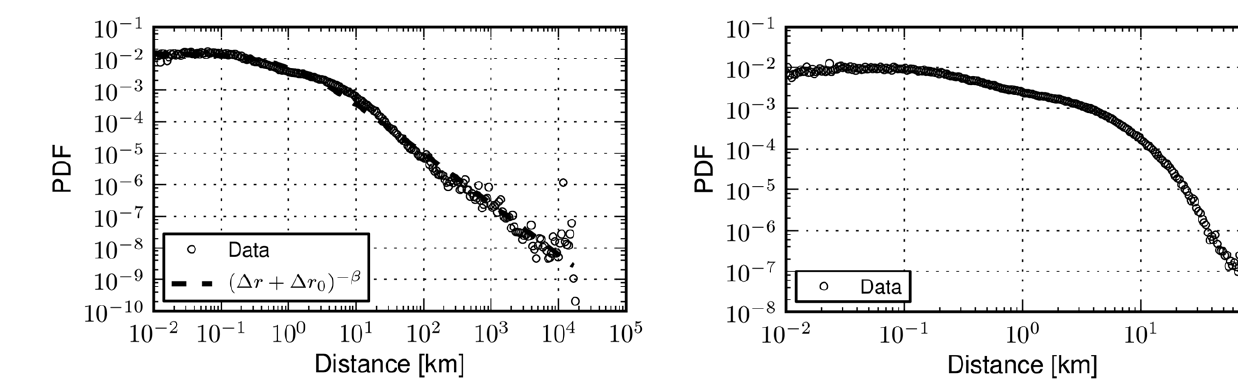
Figure 2. Urban movements. The probability density function (PDF) of human displacements in cities (intracity). For two successive location broadcasts (check-ins) a sample is included if the locations involved in the transition belong to the same city. Approximately 10 million of those transitions have been measured. The poor power-law fit of the data ( b ~ 4 : 67 , D r 0 ~ 18 : 42 ) suggests that the distribution of intracity displacements can not be fully described by a power law. Short transitions which correspond to a large portion of the movements distribution are not captured by such process.